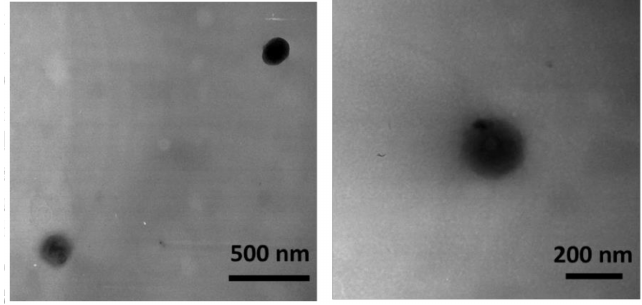
Figure 1. Transmission electron microscopy (TEM) image of acyclovir-loaded chitosan